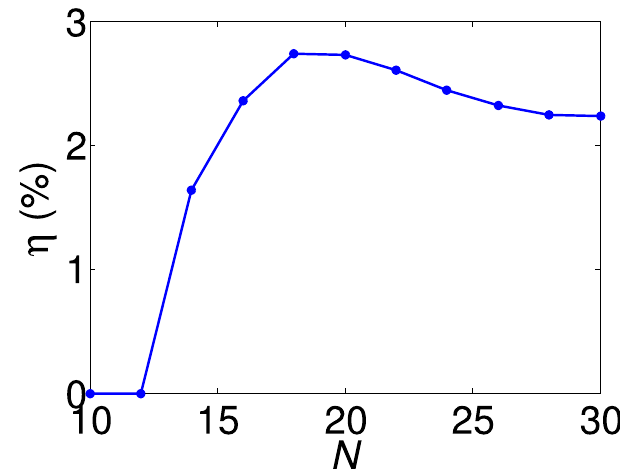
fundamental.FIG. 11. (Color) Simulation results for extraction (cid:10) versus num- ber of undulator periods N . For the given set of parameters, the optimal number of periods is N (cid:6) 18 , much shorter than a typical FEL